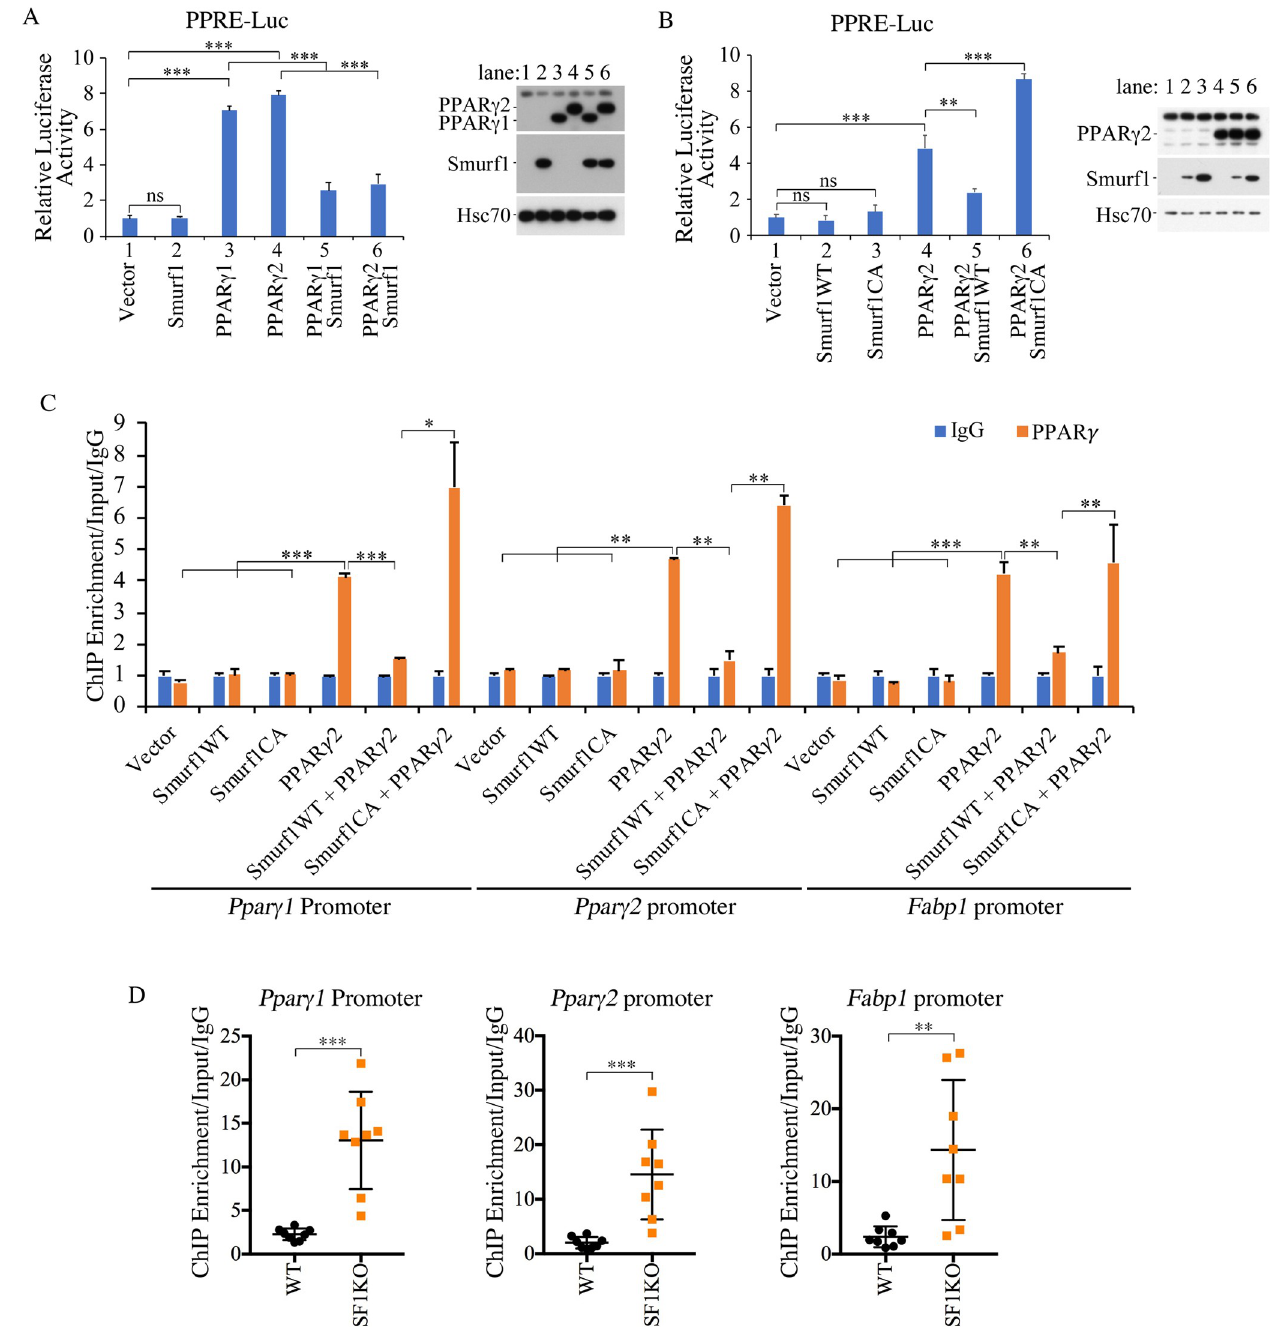
Fig 6. Smurf1 inhibits PPAR γ transcriptional activity. (A) Smurf1 inhibits PPAR γ -induced transcriptional activity in AML12 cells. Relative luciferease activities were measured 1 day after transfection. Data are presented as mean ± SD; statistical significance of differences is indicated by � p < 0.05, �� p < 0.01, ��� p < 0.001. Expression of transfected Smurf1 and PPAR γ in these cells is shown at right. (B) E3 ligase activity of Smurf1 is required for its inhibition of PPAR γ transcriptional activity. Luciferase activities were measured and showed as above. Expression of transfected Smurf1 and PPAR γ in these cells are shown at right. (C) ChIP analyses of PPAR γ binding to its own or Fabp1 promoter in AML12 cells after transfecting the plasmids as indicated. (D) ChIP analyses of PPAR γ binding to its own or Fabp1 promoter in liver tissues from WT and Smurf1KO mice ( n = 8 per group). Data are presented as mean ± SD; statistical significance of difference is indicated by � p < 0.05, �� p < 0.01, ��� p < 0.001. Original raw data can be found in S1 Data. ChIP, chromatin immunoprecipitation; E3, ubiquitin ligase; Hsc70, heat shock cognate 71 kDa protein; IgG, Immunoglobulin G; KO, knockout; PPAR, peroxisome proliferator-activated receptor; PPRE-Luc, PPAR response element-luciferase reporter; SF1KO, Smurf1 KO; Smurf, Smad ubiquitin regulatory factor; WT, wild-type.